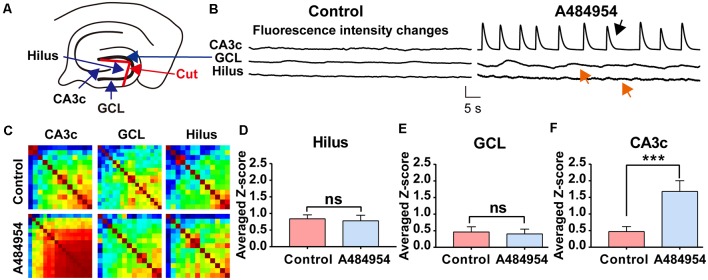
Isolation of the hilus in the DG did not prevent synchronized fluorescence transients in the CA3 region after A484954 application. (A) Uncoupling of CA3 and hilus was achieved by a cut between the two wings of the granular cell layer (GCL) as indicated in the sketch (red line and red arrow). (B) The drug-induced synchronized activity was observable in the CA3 area (black arrow) but not in the hilus region (red arrow). Vertical scale bar: ΔF/F0 = 4, horizontal scale bar: 5 s. (C) The heat maps for before and after drug application illustrate the different synchronized activity of the analyzed regions. (D)
Z-scores in the Hilus for all corresponding experiments (control: 0.84 ± 0.12; drug: 0.78 ± 0.17; ns, unpaired-t-test). (E) The bar graph summarizes the Z scores in GCL for all corresponding experiments (control: 0.40 ± 0.16; drug: 0.39 ± 0.10; ns, unpaired t-test). (F) The averaged Z scores over all experiments between sessions of control and drug application in the CA3 region differ significantly (control: 0.47 ± 0.15; drug: 1.67 ± 0.32; ***P < 0.01, unpaired-t-test; n = 8).